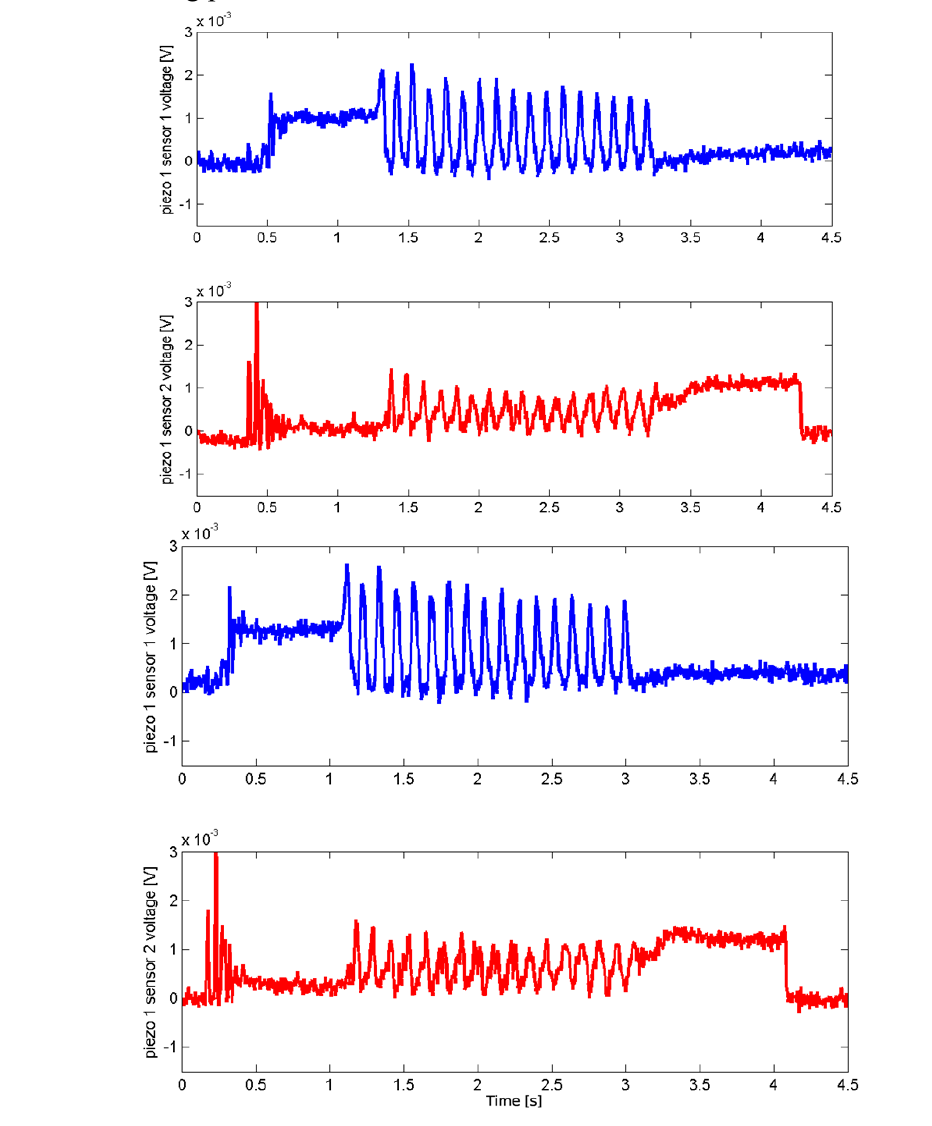
Figure 8. Time plot of the readings from piezoresistor 1 of MEMS sensors 1 and 2 of the array. The plots refer to data series 6 (a) and 7 (b), where a grating of 3.6 mm spatial periodicity was applied with translational speed of 30 mm/s, according to Tables 2 and 3. It is noticeable to observe the high repeatability, as well as the similarity with Figure 9(a), which only differs for the stimulus translational speed and thus results in an expansion of the time scale during phase